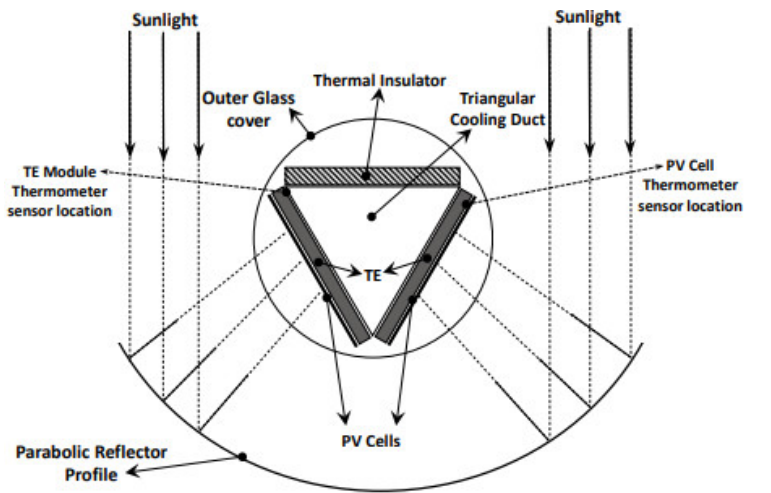
Figure 13. The cross-sectional view of CPVT system tested in [95]. Reprinted with permission from Ref. [95]. 2017, Elsevier.